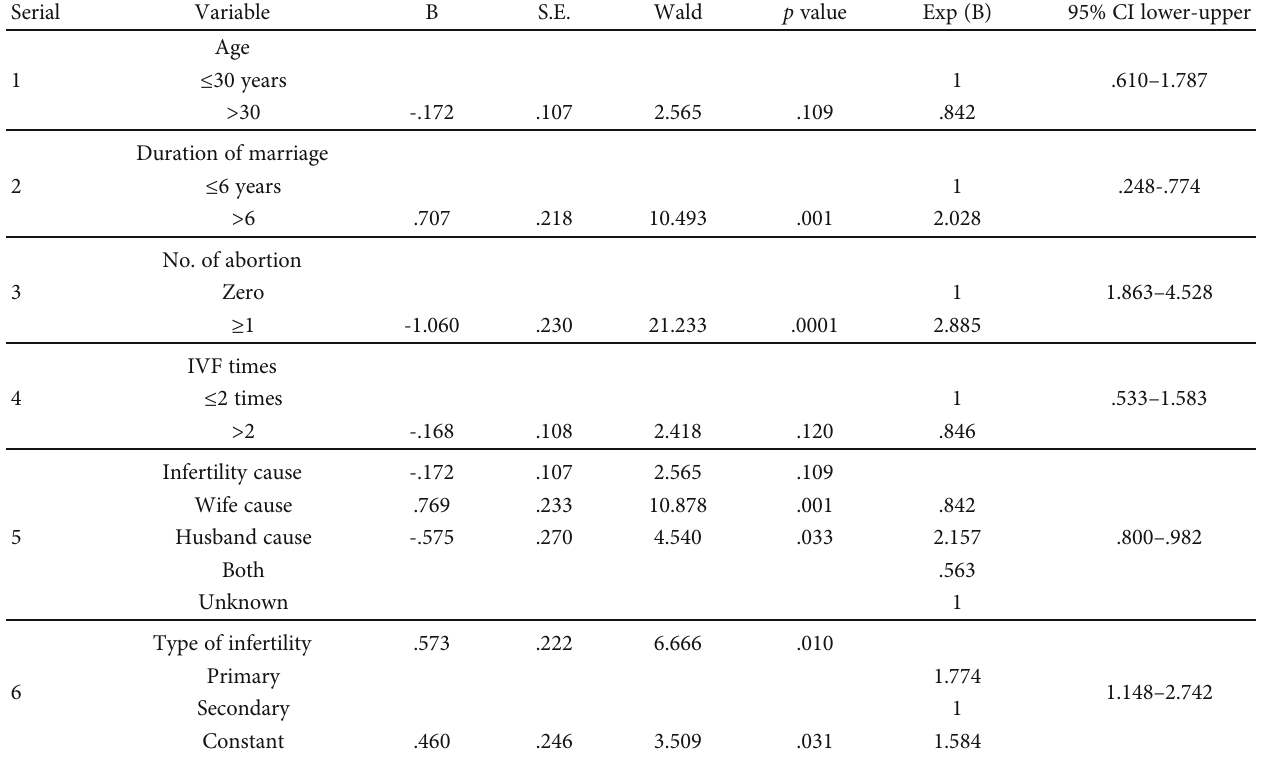
Table 3: Multivariate logistic regression analysis for potential predictors to